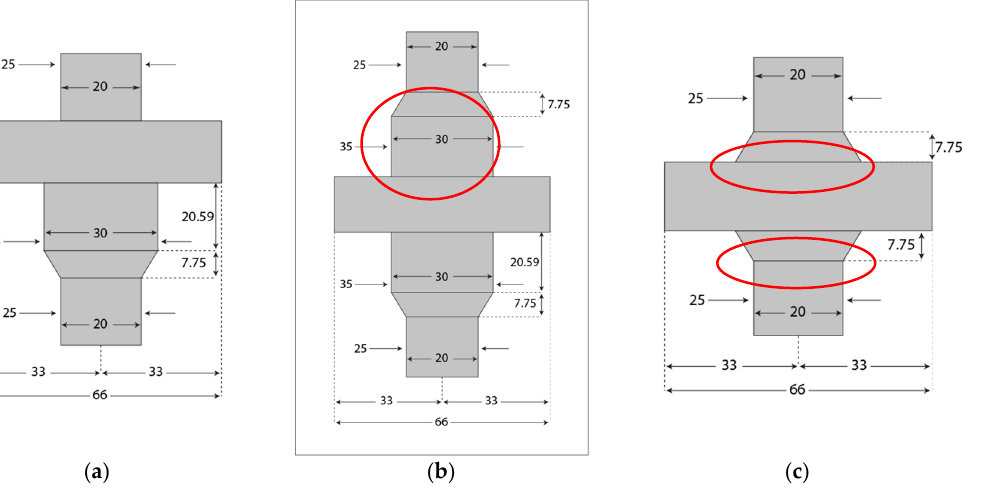
Figure 23. Changes in valve geometry. ( a ) First valve geometry; ( b ) second valve geometry; ( c ) third valve geometry.